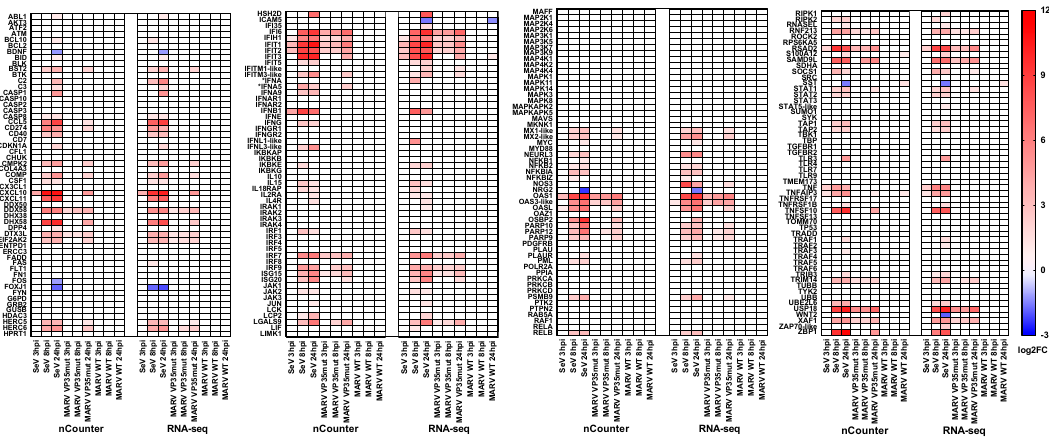
Figure 3. The nCounter codeset matched with DEGs from RNA-seq. A total of 221 ERB genes were chosen for the nCounter codeset, most of them involved in the antiviral responses. The scale is log2FC. *IFNA denotes the combined expression of the IFNA subtypes in the RNA-seq. No individual IFNA was significantly differentially regulated. * LTK and IFI44 probes were developed using the P. alecto genome; these transcripts are not present in the transcriptome used for RNA-seq alignment. Genes described as “-like” are not officially annotated and the locus tags correspond as follows: MX1 -like: